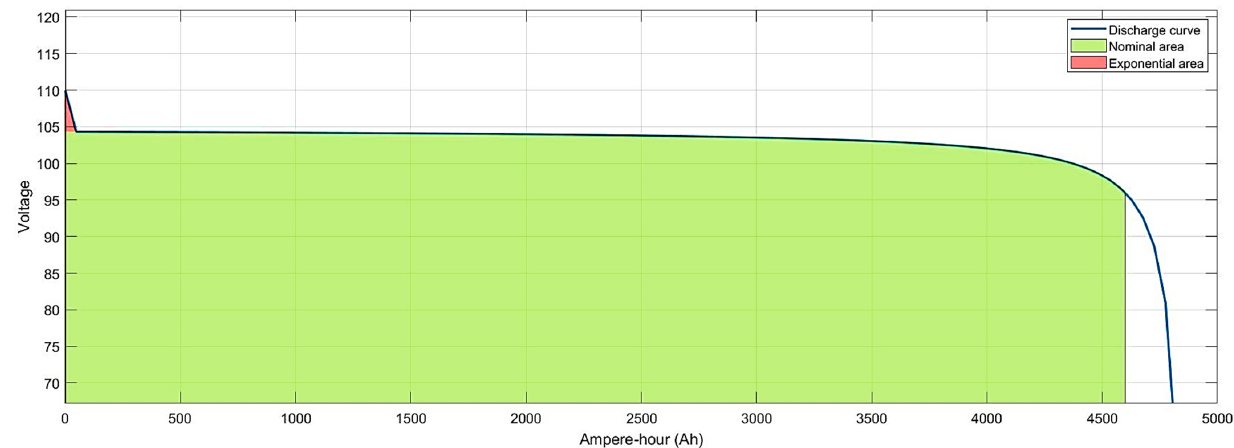
Figure 4. The battery current curves at 0.083333C (400A) [32].